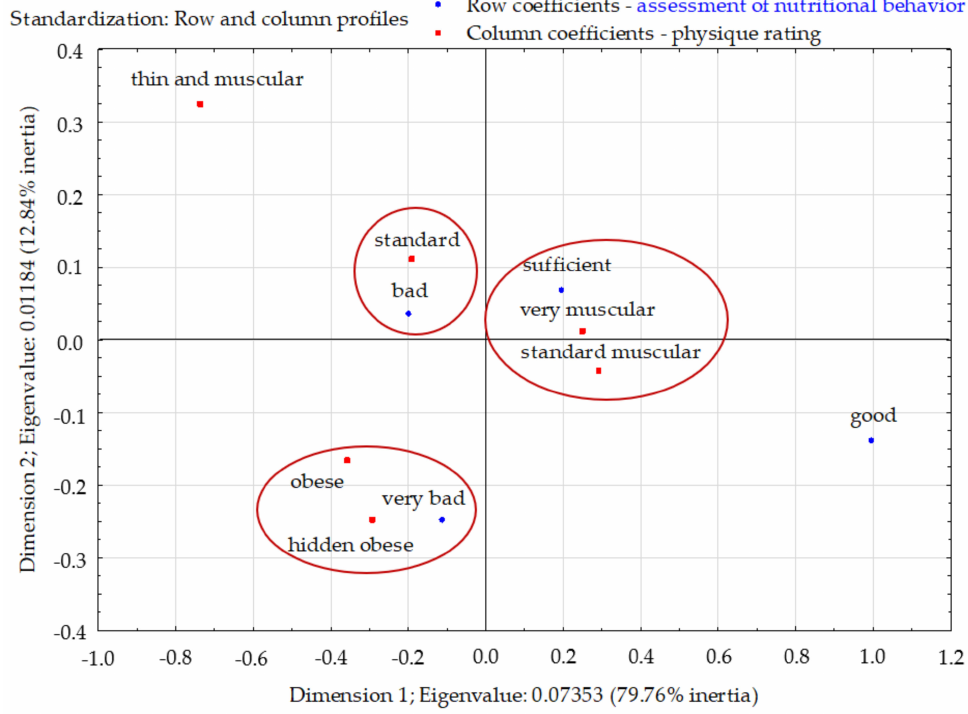
Figure 10. Evaluation of the nutritional behavior of young Poles and their physique rating (corre- spondence analysis). Source: own study based on